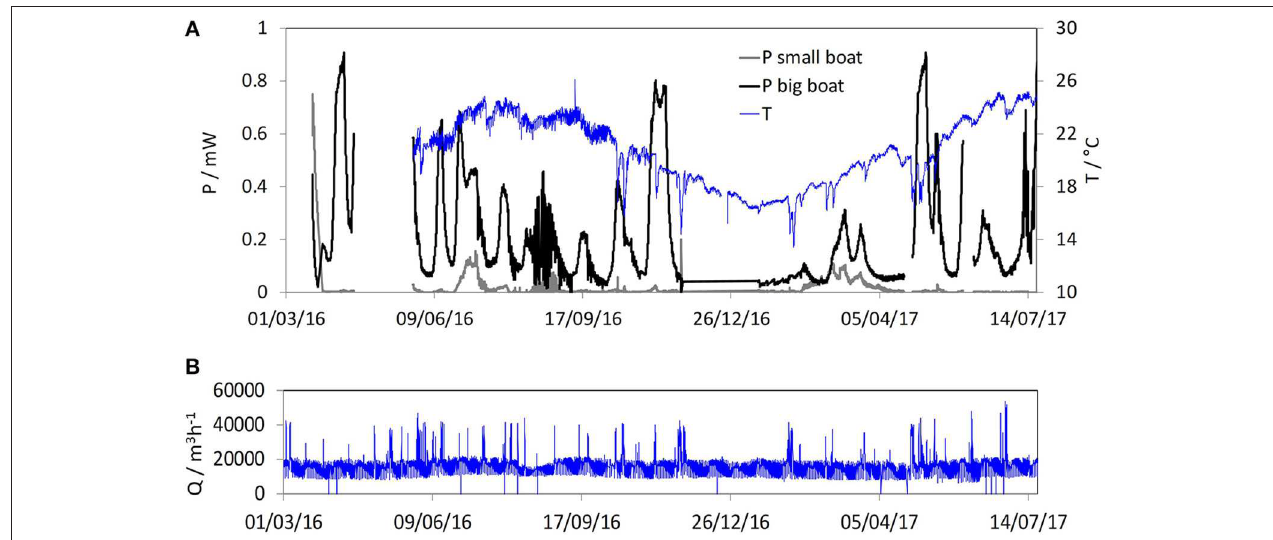
FIGURE 2 | Power trends of the Small boat and Large boat MFCs during more than 1 year (April 2016–July 2017) in an anoxic tank (Milano-Nosedo WWTP) (A) ; trends of temperature and wastewater flow incoming in the plant is also reported (B) .